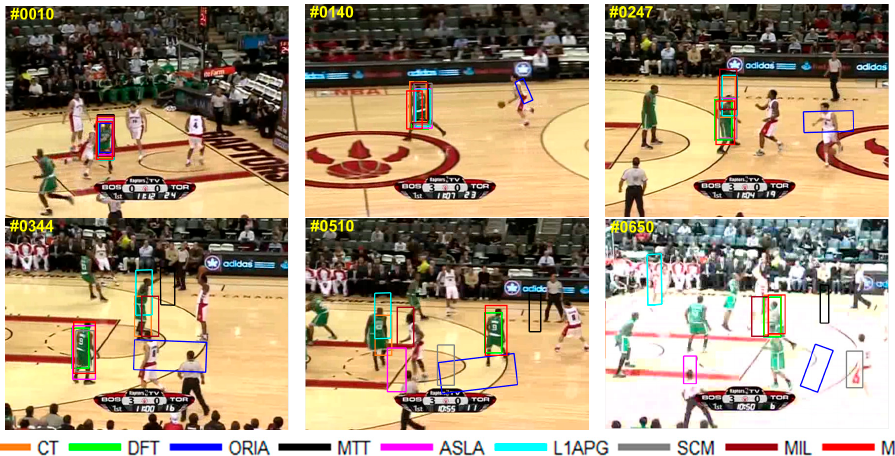
Figure 13. Tracking results on Basketball .